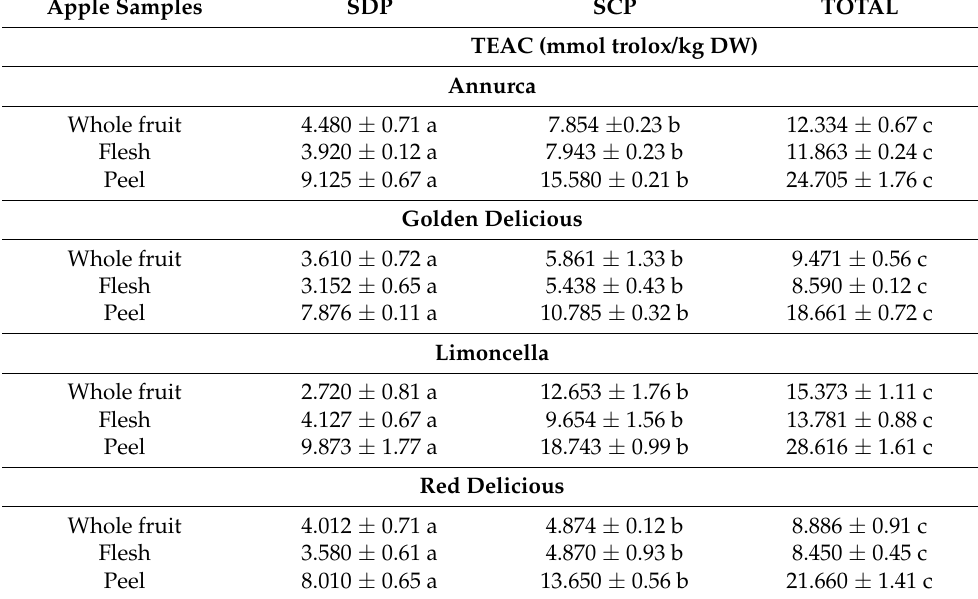
Table 8. Antioxidant activity measured with DPPH assay in Limoncella, Red Delicious, Golden Delicious, and Annurca upon in vitro digestion of apple samples (flesh, peel, and whole fruit). Each value represents the mean ± SD of three replicates. For each line, different letters indicate significantly different values ( p < 0.05) according to Tukey’s